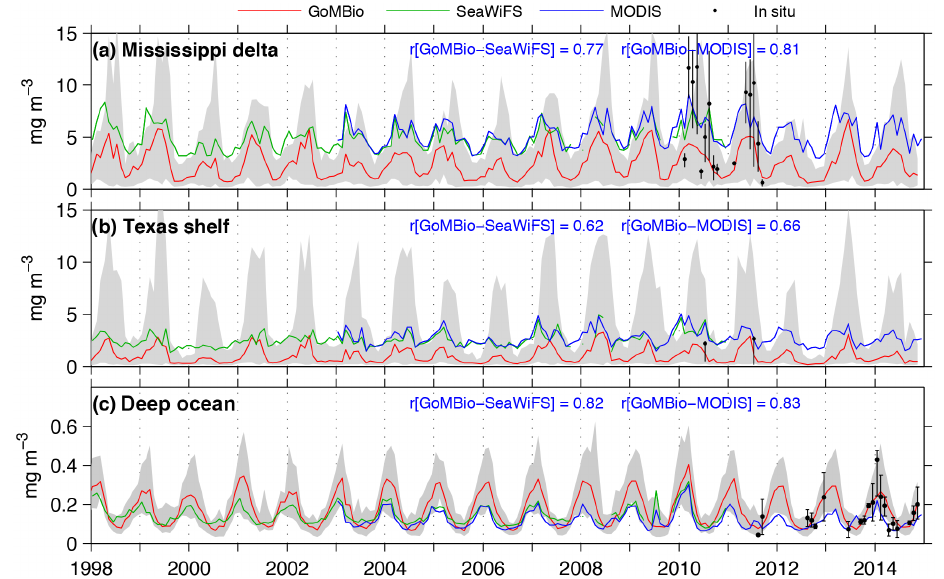
Figure 3. Monthly chlorophyll time series derived from model (GoMBio, red line), SeaWiFS (green line), and MODIS (blue line). Gray area depicts the model chlorophyll range. Correlation coefficient between model and satellite time series is indicated at each panel. Black dots with vertical bars depict the monthly mean and interquartile range of in situ chlorophyll from the Coastal Waters Consortium dataset (a, b) and APEX profiling floats (Lagrangian Approach to Study the Gulf of Mexico Deep Circulation project, c ). Ticks on the ordinate mark 1 January of each year.